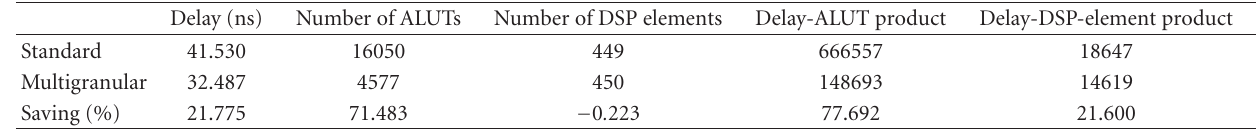
Table 3: Result of a 256 × 256-bit multigranular signed